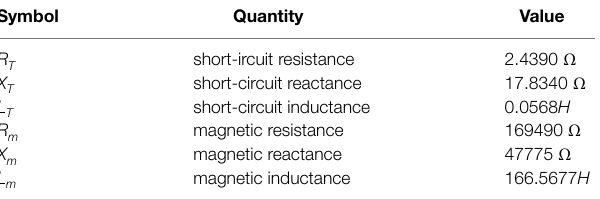
TABLE 4 | Equivalent circuit parameters of